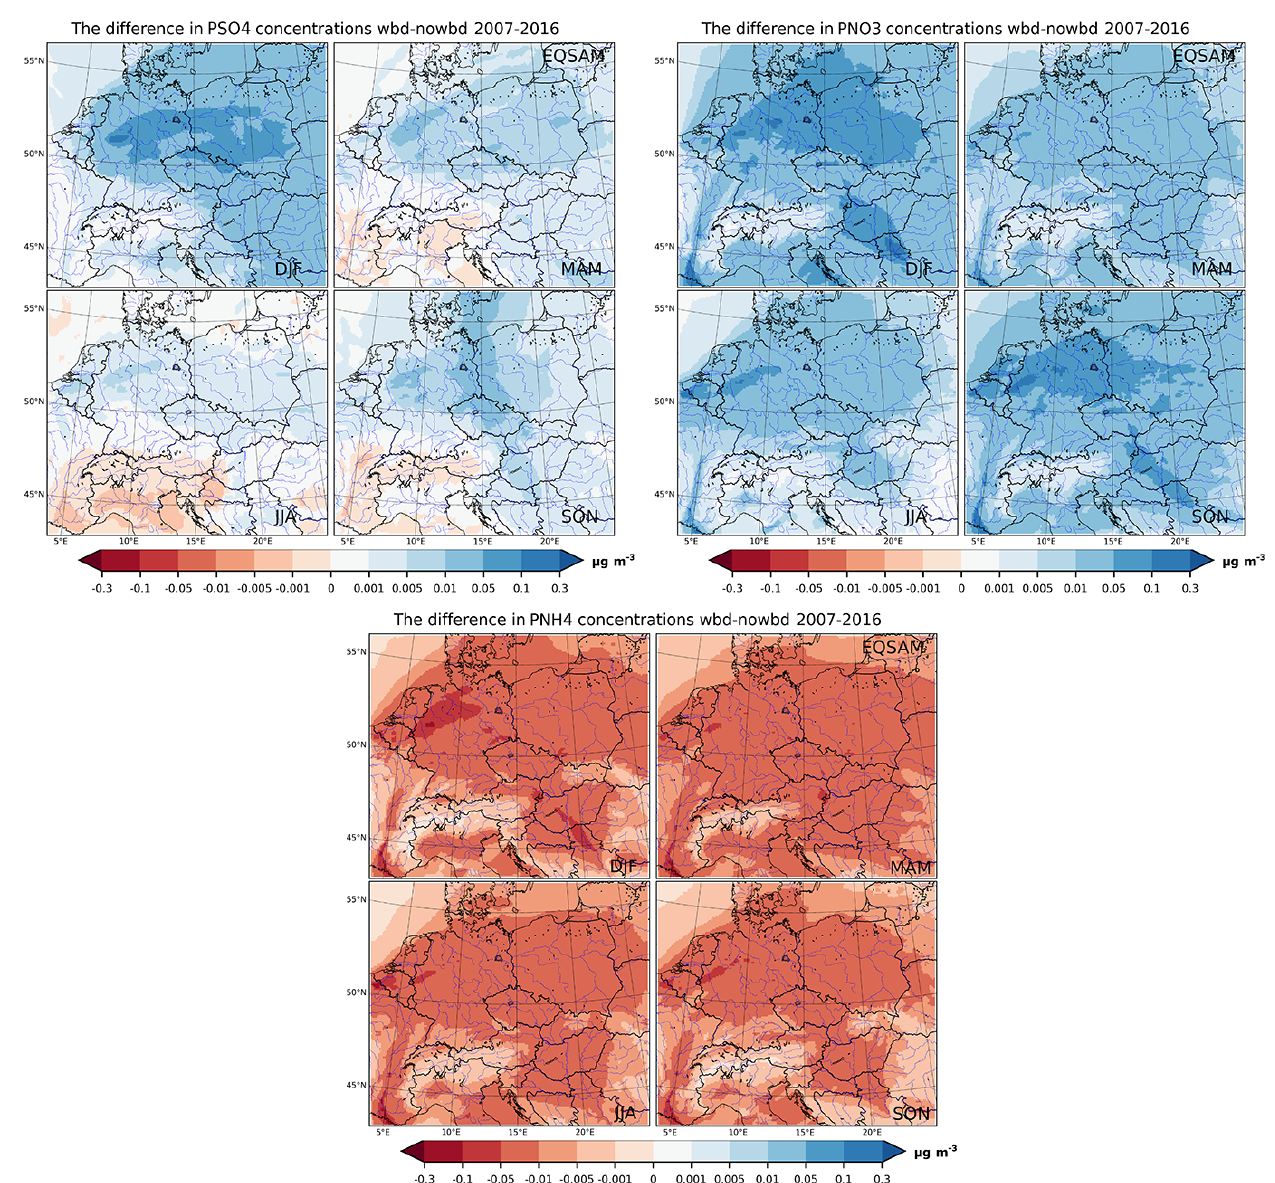
Figure 22. The WBD emission impact on secondary inorganic aerosol concentrations (PSO 4 , PNO 3 and PNH 4 ) with EQSAM, seasonally averaged, in micrograms per cubic metre for